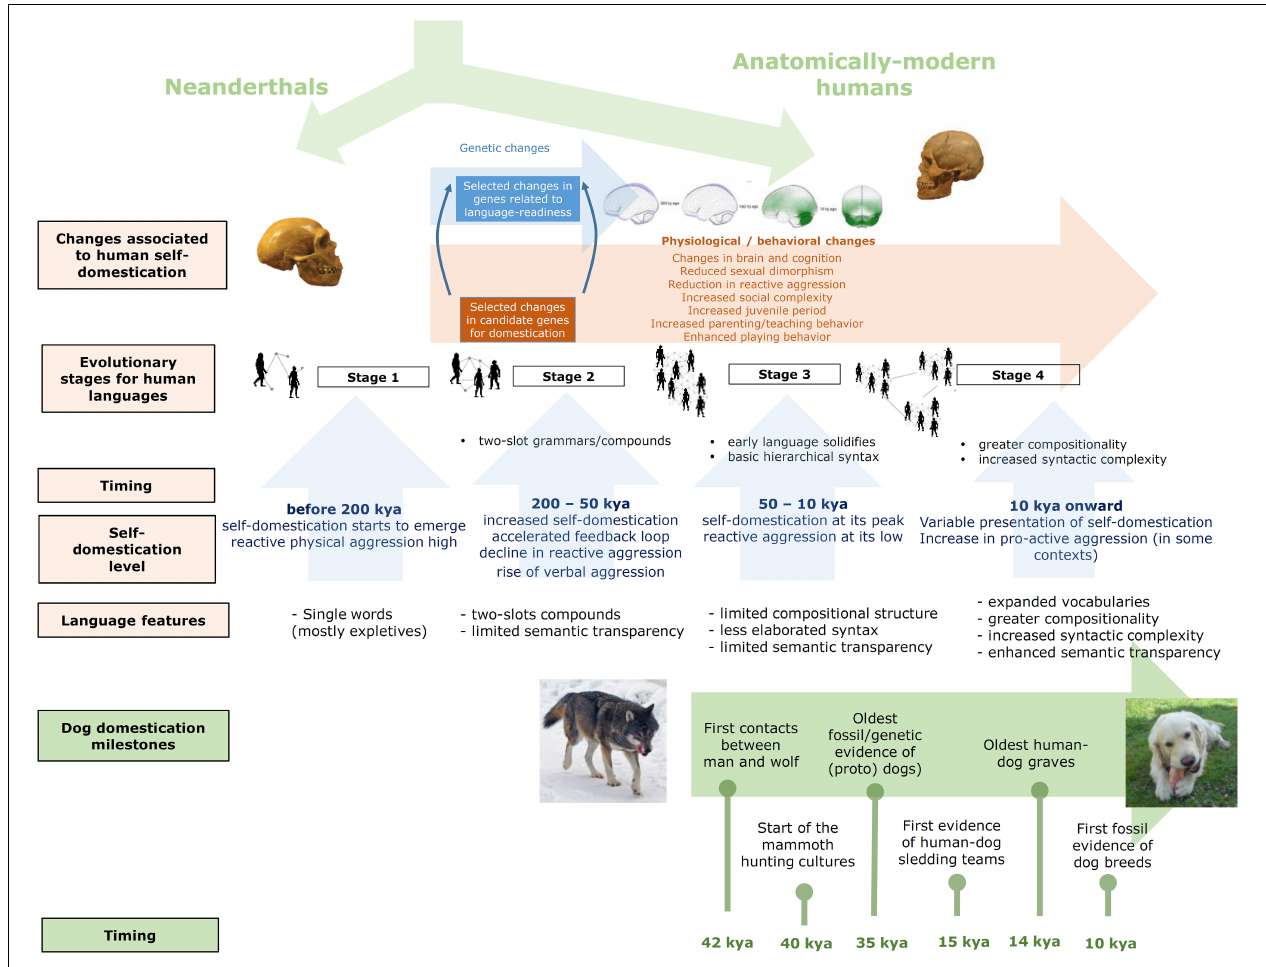
FIGURE 1 | A graphical summary of our model of language evolution under the forces of self-domestication and the hypothesized feedback effect with dog domestication. The images of the wolf and the dog are from Wikipedia (CC BY-SA